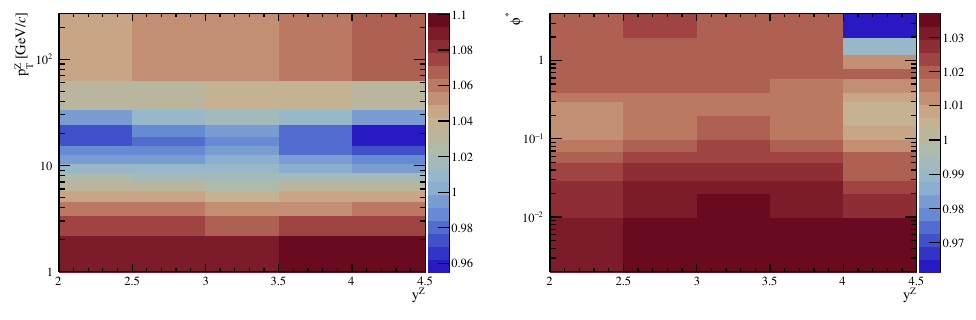
Figure 11 . Final state radiation correction estimated for double differential cross section measure- ment for (left) y Z − p Z measurement, and for (right) y Z − φ ∗ T